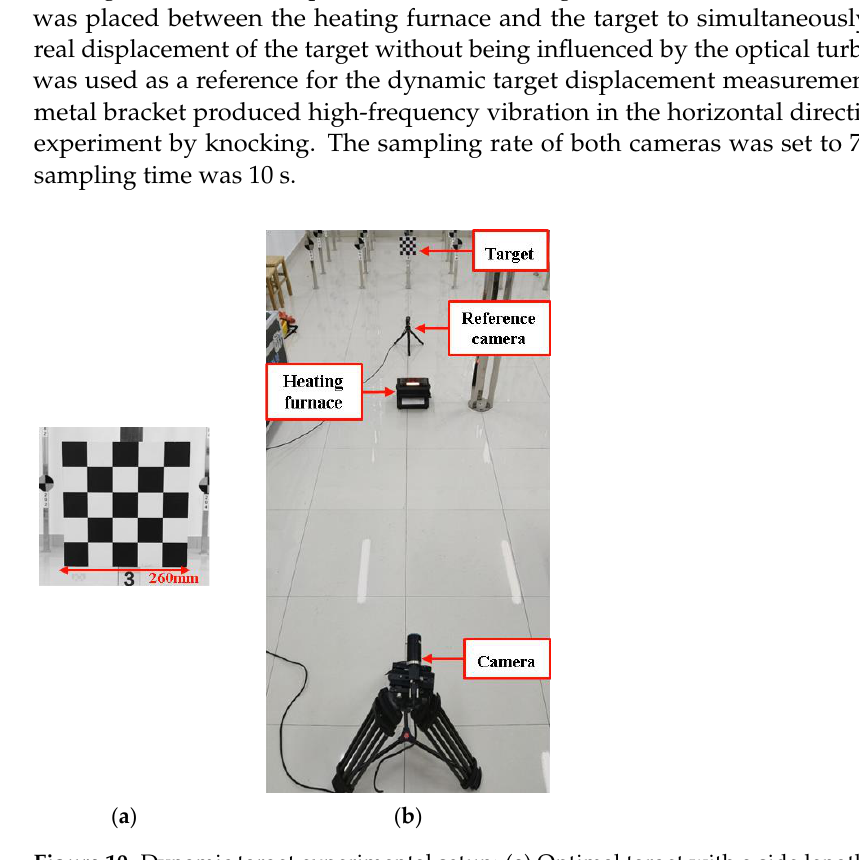
Figure 10. Dynamic target experimental setup: ( a ) Optimal target with a side length of 260 mm; ( b ) Experimental setup.